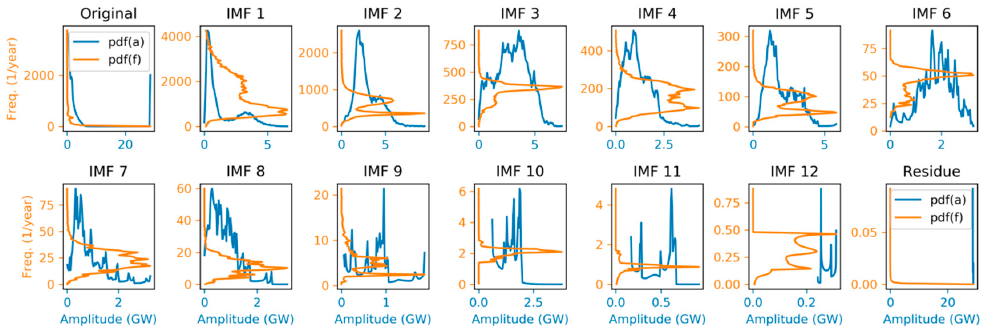
Figure 19. Instantaneous amplitude Probability Density Function (PDF) of the electricity demand IMFs (blue line). In a rotated way (orange line), frequency PDFs (horizontal axis) versus instantaneous frequency (vertical axis) are also depicted.